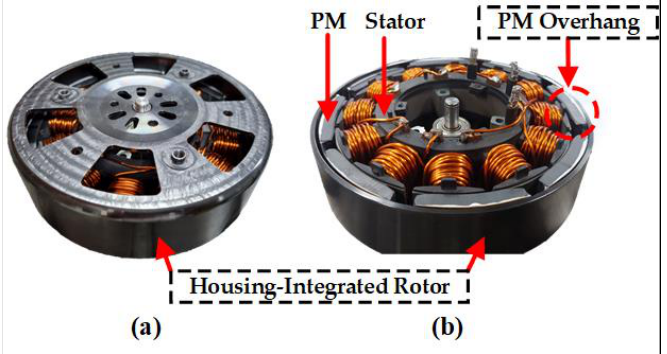
Figure 10. Manufactured analysis model ( a ) upper view and ( b ) lower view.